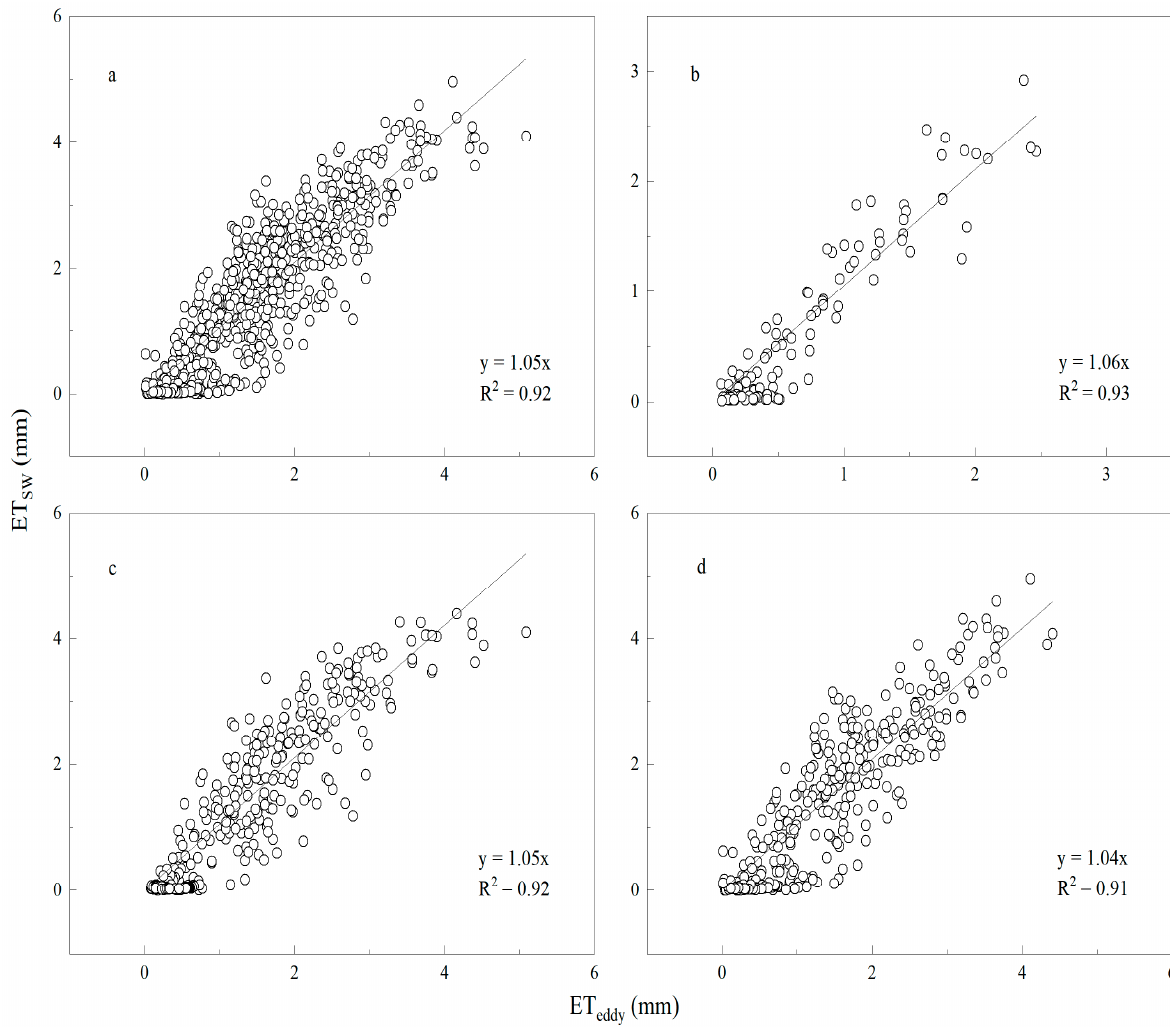
Figure 10. Relationships between evapotranspiration estimated by the S–W model ( ET SW ) and measured by eddy covariance ( ET eddy ) in the degraded meadow for ( a ) 2006–2008, ( b ) 2006, ( c ) 2007, and ( d ) 2008, respectively. Table 5. Statistical analyses of evapotranspiration estimated by the S–W model ( ET SW ) and meas- ured by the eddy covariance ( ET eddy ) in the different periods. Year